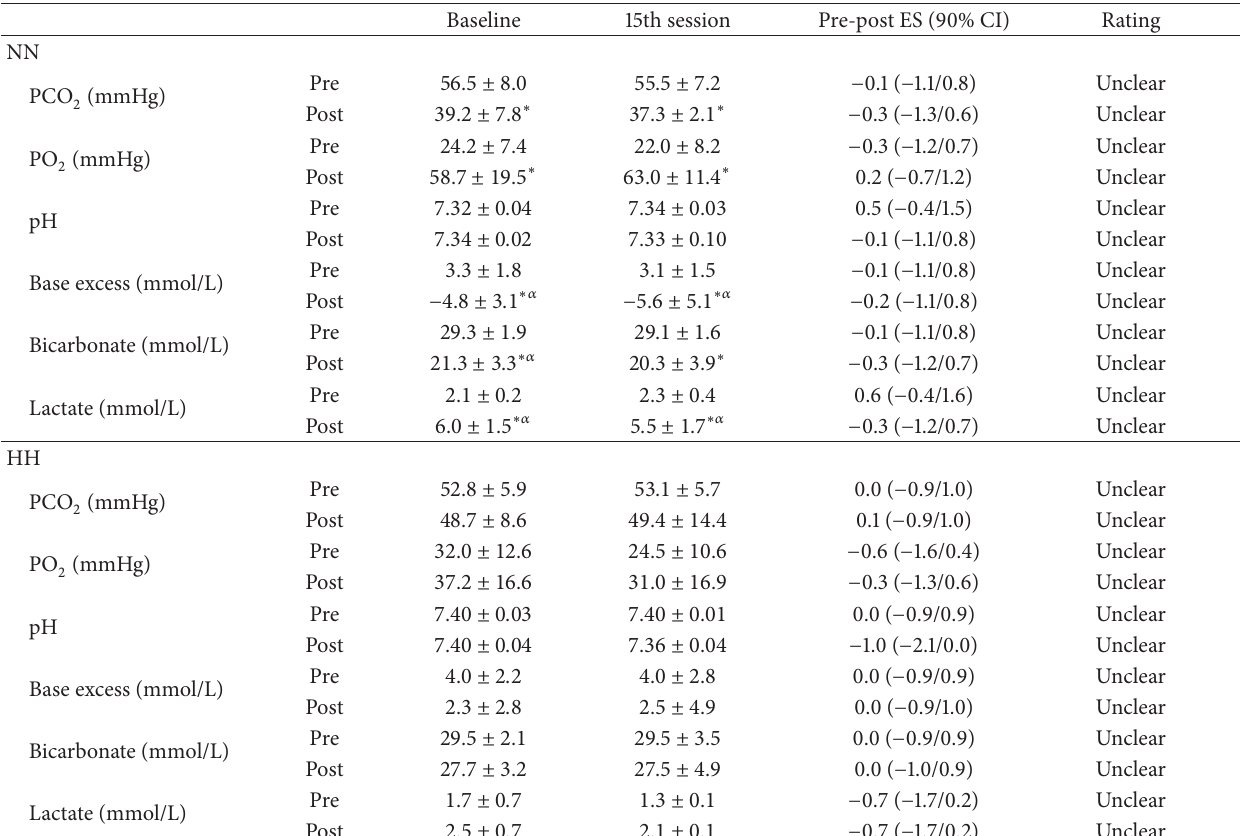
Table 3: Acid-base balance immediately before (pre) and after (post) training session of 3 weeks of hyperbaric hyperoxia (HH) and normobaric normoxia (NN) endurance